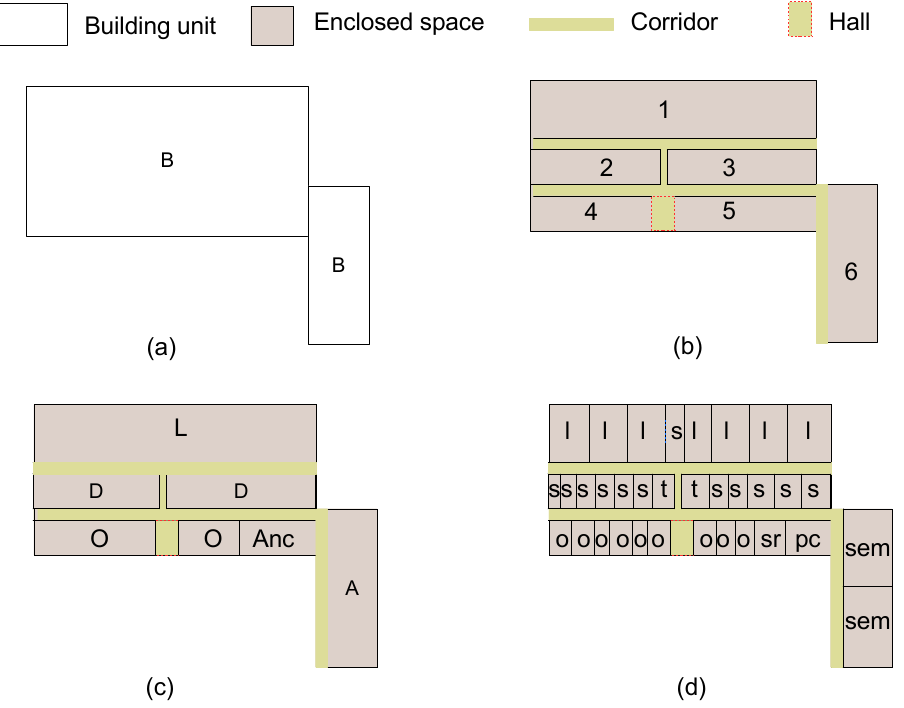
Figure 3. An example of semantic division of research buildings. ( a ) two building units in a floor. ( b ) corridors, halls, and enclosed zones in each building unit ( c ) type of each zone ( d ) single room types in each zone.